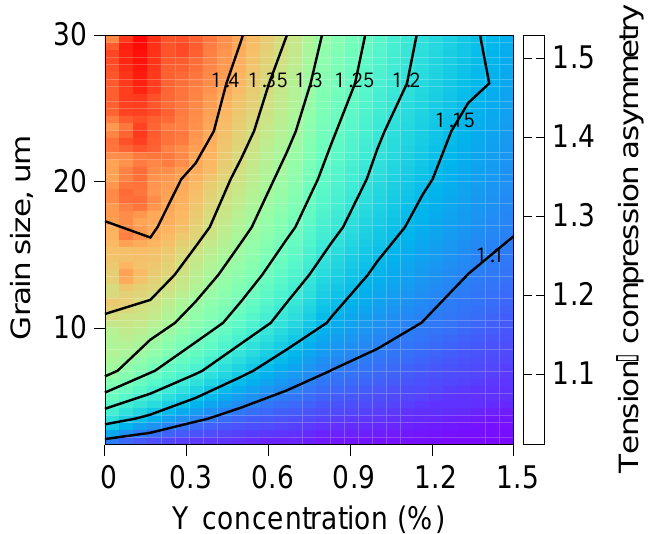
Figure 5. Distribution of rolling direction (RD) yield stress tension–compression asymmetry in the grain size and Y-content space.